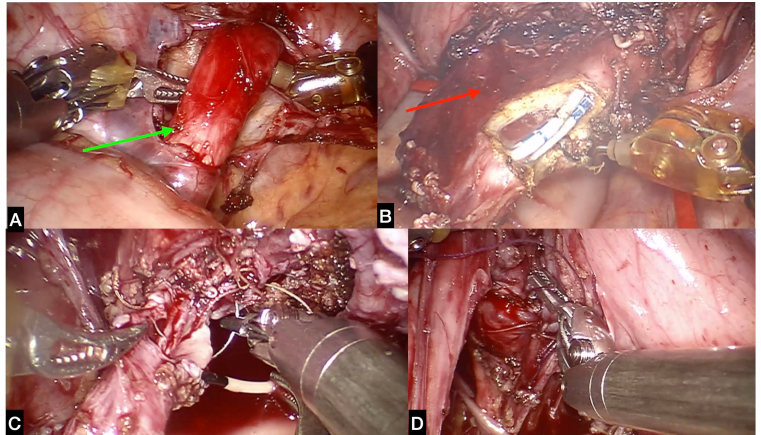
Figure 6. Ureteral reimplantation in patient with bladder diverticulum. ( A ) The ureter (green arrow) is isolated and ( B ) detached from the bladder with exeresis of the diverticulum (red arrow); ( C ) uretero- vesical anastomosis and ( D ) extravesical reimplantation according to Lich–Gregoir is then